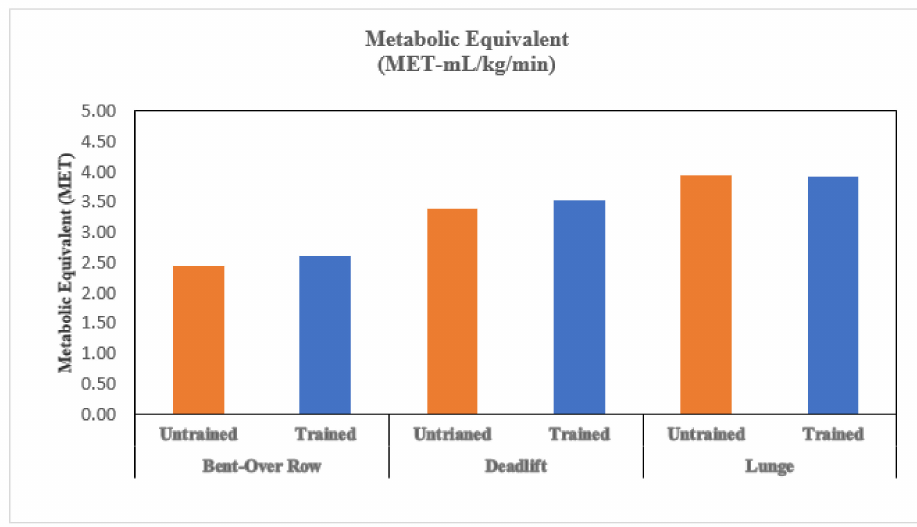
Figure 2. Metabolic Equivalent (MET) of weight training exercises. ( n = 10).